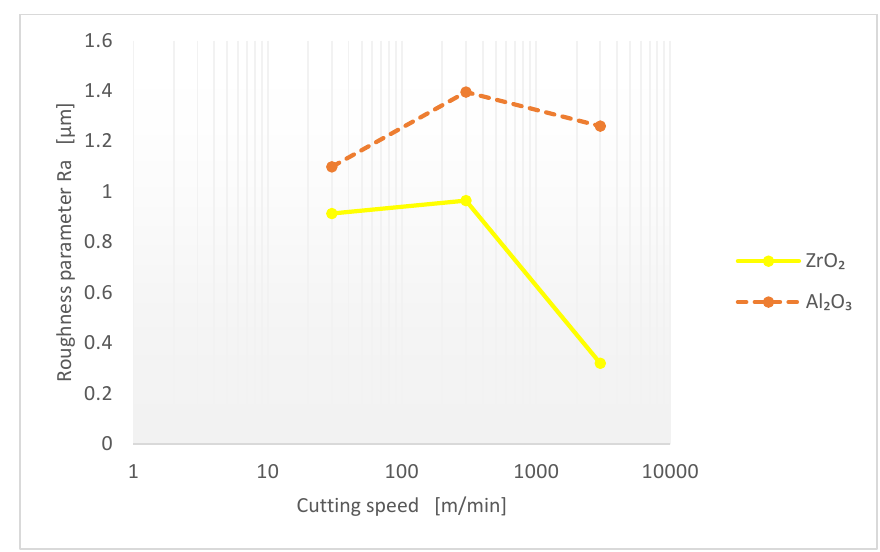
Figure 7. Influence of cutting speed on surface roughness parameter Ra. Other surface roughness parameters were similar in behavior to the Ra parameter.